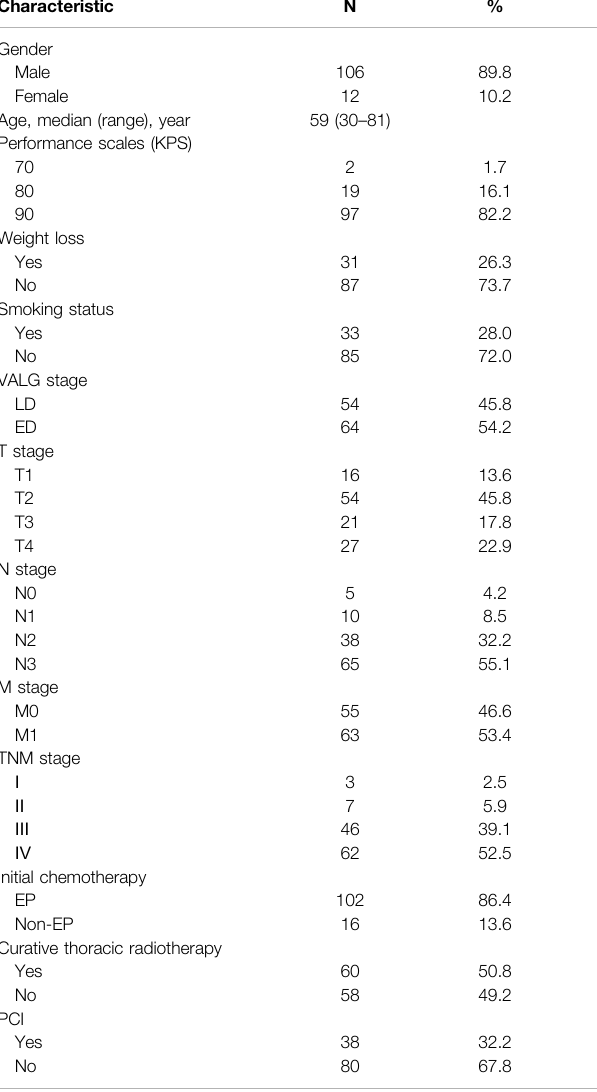
TABLE 1 | Characteristics of 118 patients with SCLC.